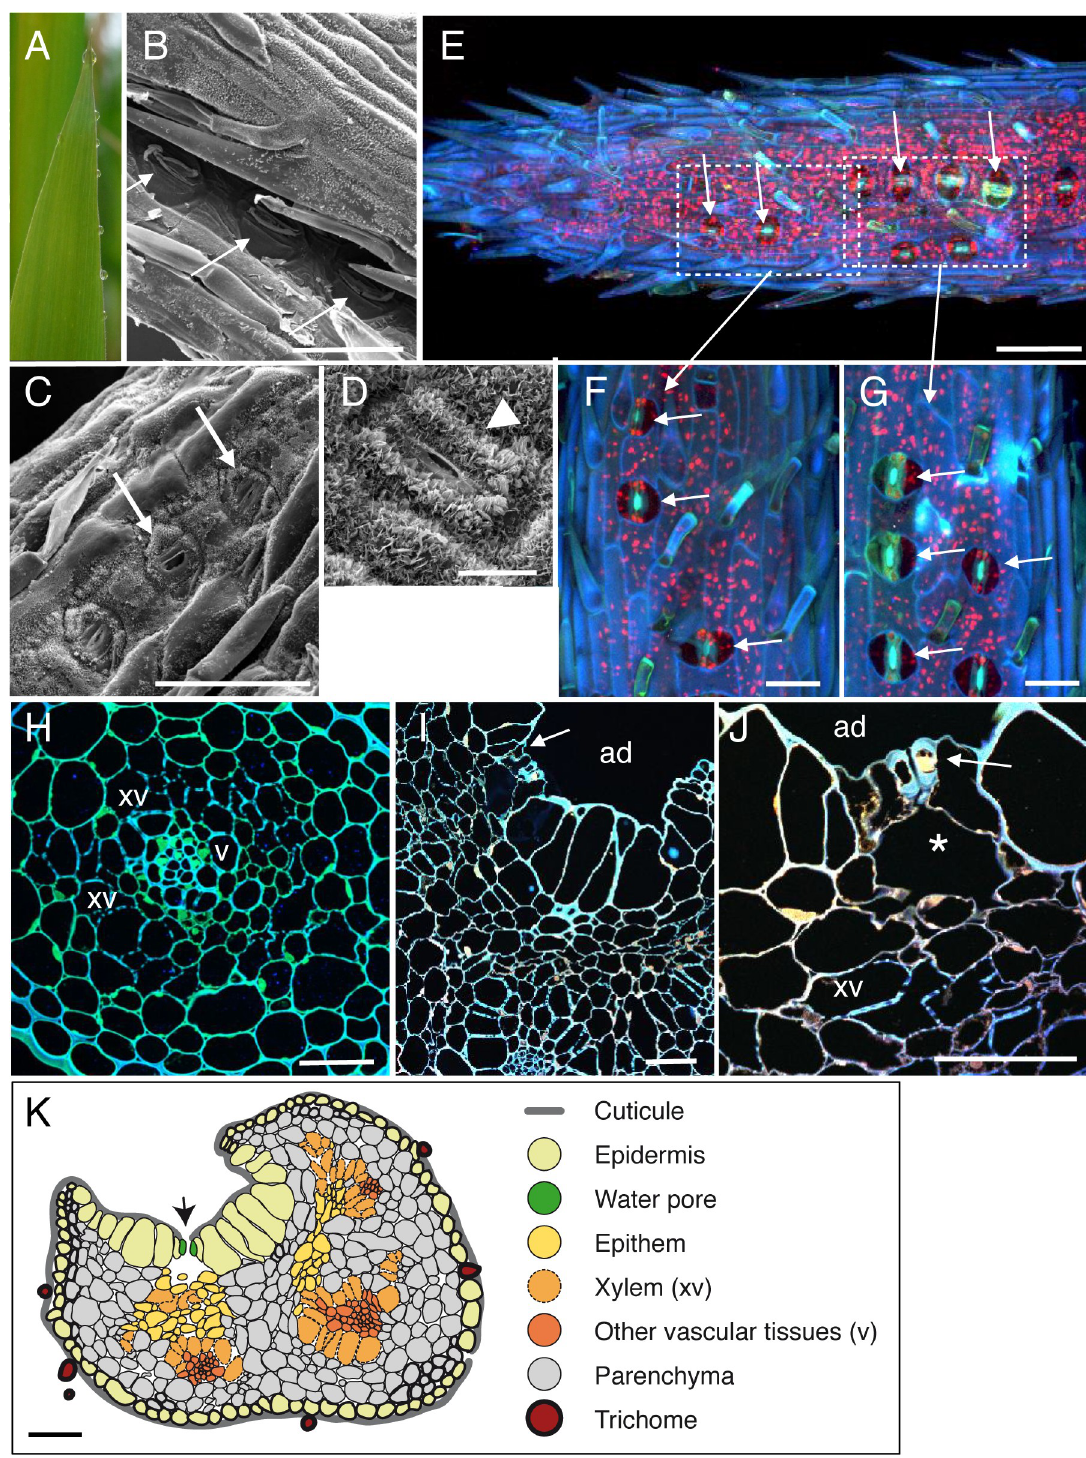
Fig 4. Anatomic description of sugarcane apical hydathodes by confocal and Scanning Electron Microscopy (SEM). (A) A guttation droplet at the leaf tip. (B-C) The leaf tip was imaged by SEM on the adaxial face at 200 μ m (B) and 300 μ m (C) from the spike tip. Water pores can be observed. (D) Observation of a stomate was performed on distal parts of leaves relative to panels B-C. (E-G) Confocal images of fresh leaf tip at 250–300 μ m from the spike tip. Details from water pores (F-G). (H-I) Transversal sections (1- μ m thickness) of fixed tissue at 150–200 μ m (H) and 800 μ m (I) from the spike tip were observed by confocal microscopy. White arrows, arrowheads and